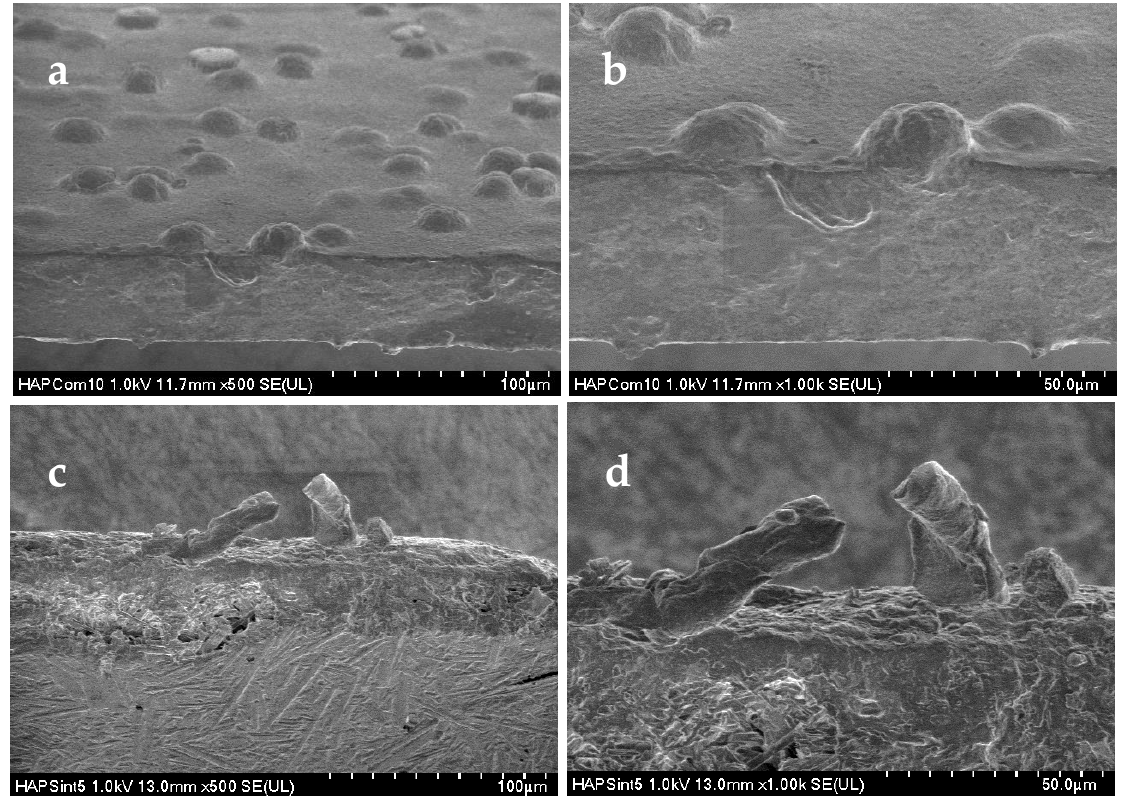
Figure 11. SEM micrographs of the fracture surfaces produced by tensile tests on the reference material with 20% by weight of commercial HAp ( a , b ) and composite material made of 20% by weight of nanofibers ( c , d ). Notice the HAp nanofibers attached to the polymer matrix on the fracture surface.